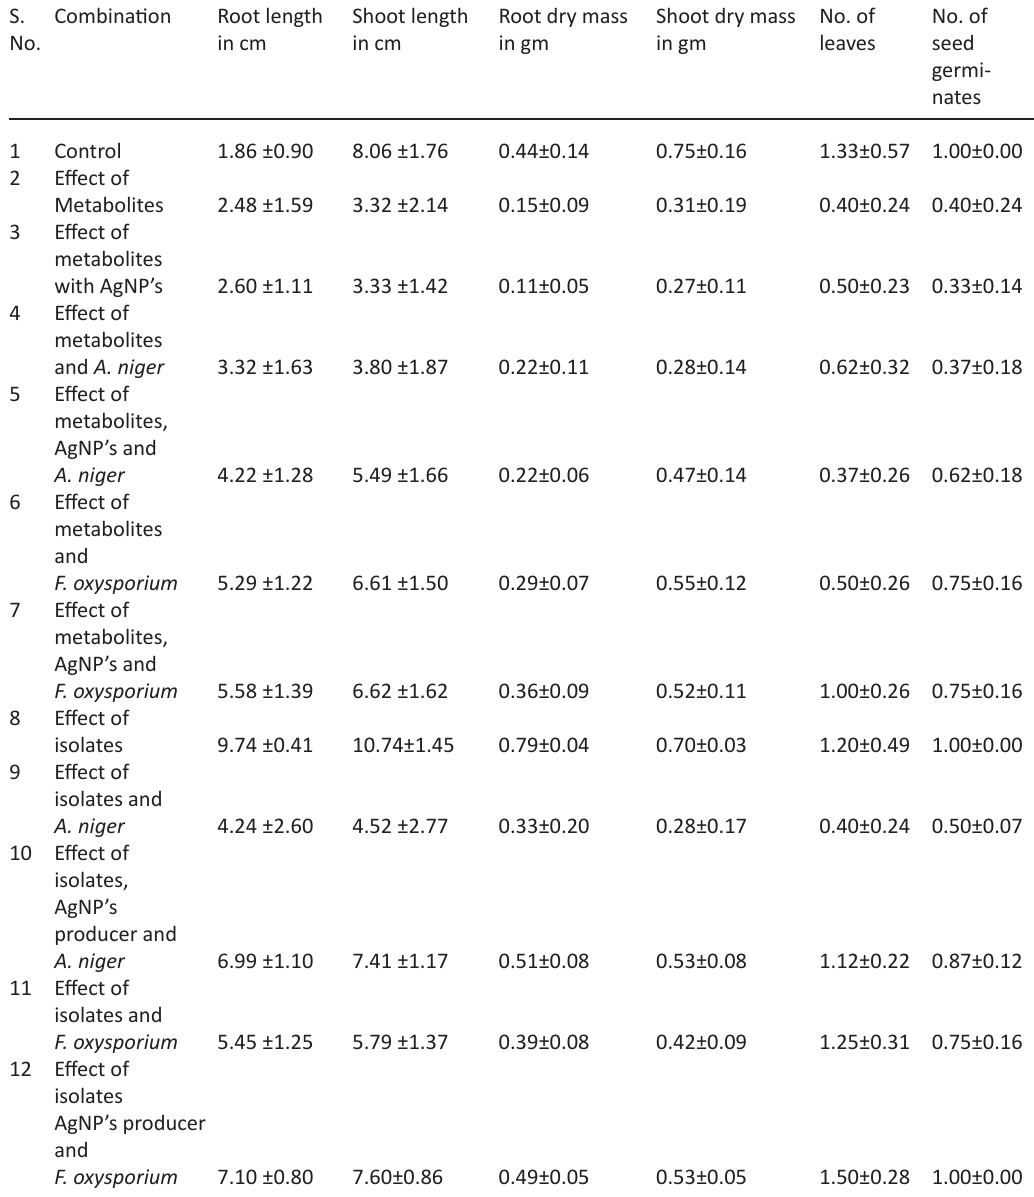
Table 5. Effect of metabolite, isolates and fungi on germination of cotton seeds S. Root length Shoot length Root dry mass Shoot dry mass No. of No. of